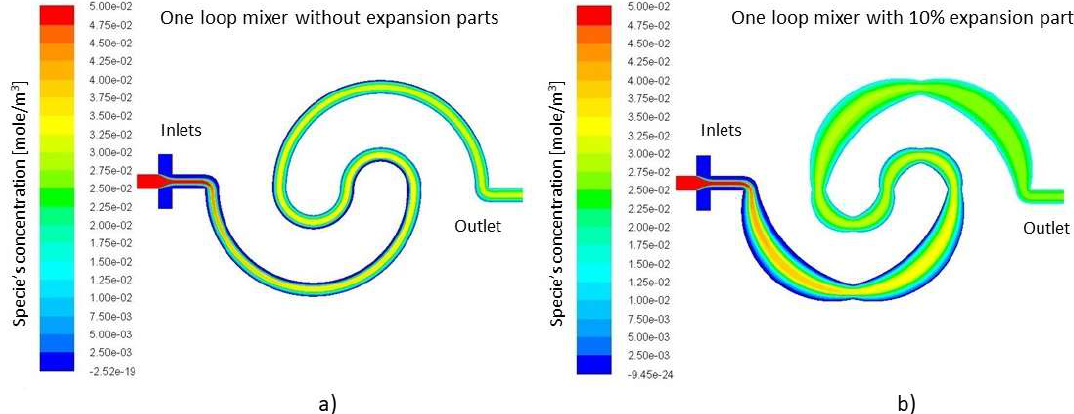
Figure 3. Simulation of the mixing of dyed water injected from inlet 1 and 2 and deionized water from inlet 3 at the Reynolds number of 1.0 ( a ) in one loop mixer without expansion and ( b ) one loop mixer with 10% expansion. The scalar concentration is defined as 0.05 mol for fluid 1 and 0 for fluid 2. The perfect mixing would give a scalar concentration value of 0.025.